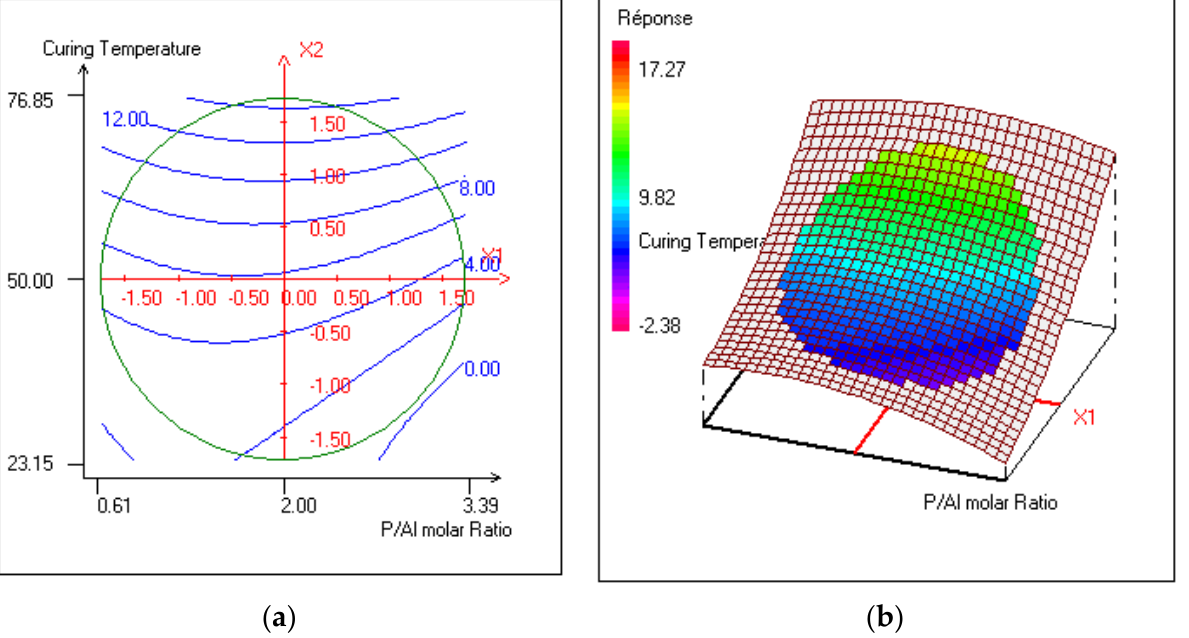
Figure 5. Variation in the response—released Al in the plan: P/Al molar ratio, curing temperature and fixed variable (curing time = 3.000 h): ( a ) 2D contour plot; ( b ) 3D curve plot.